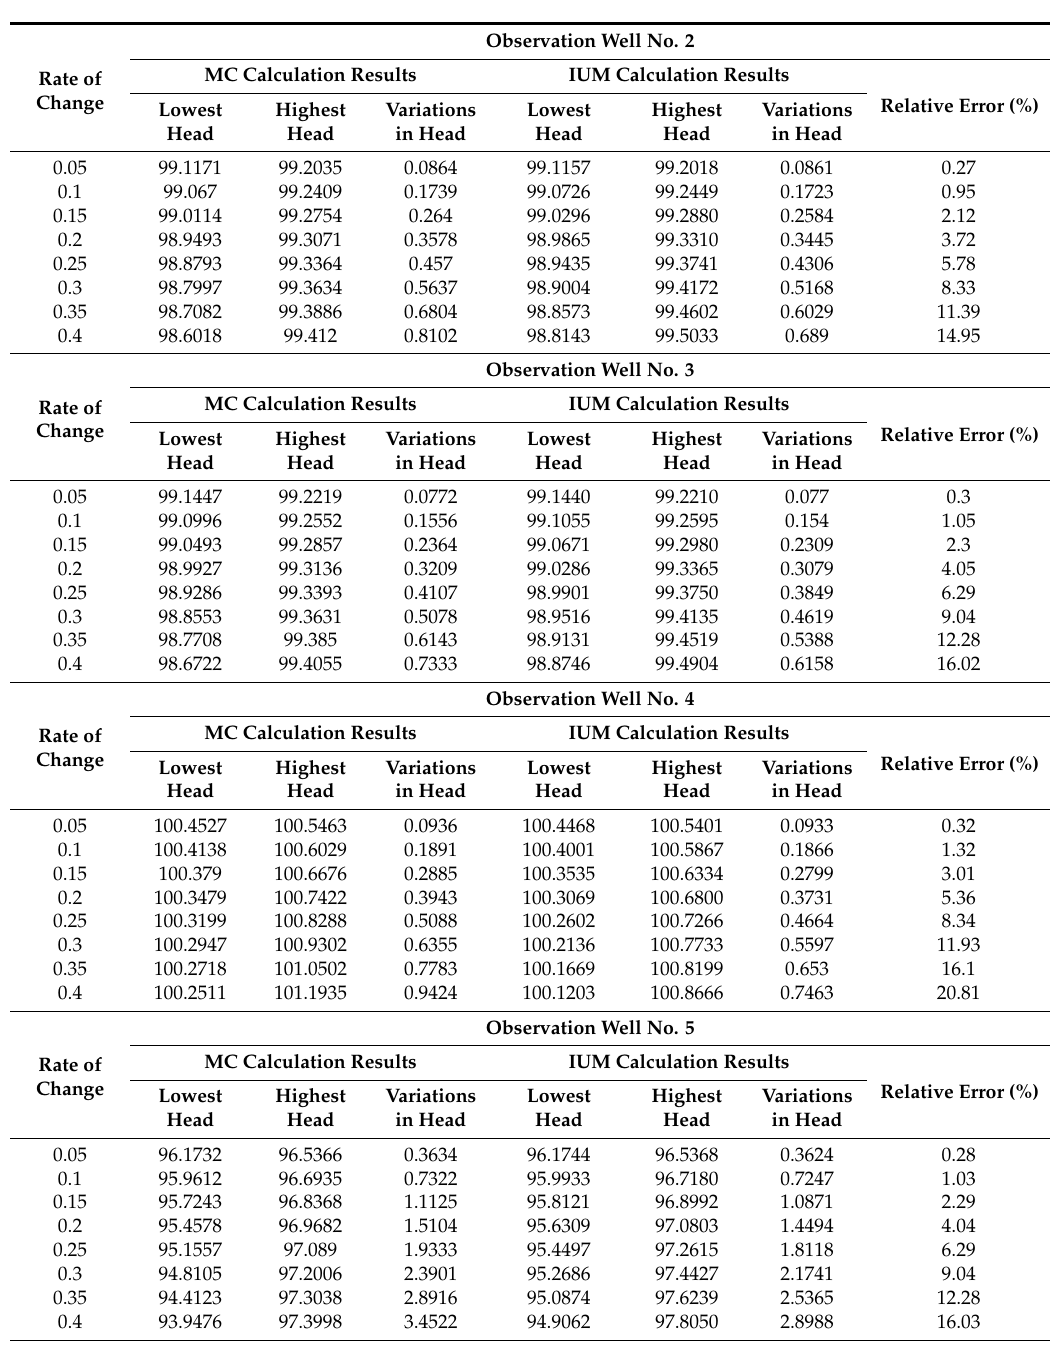
Table 4. Calculation results table for Scenario Two (unit: